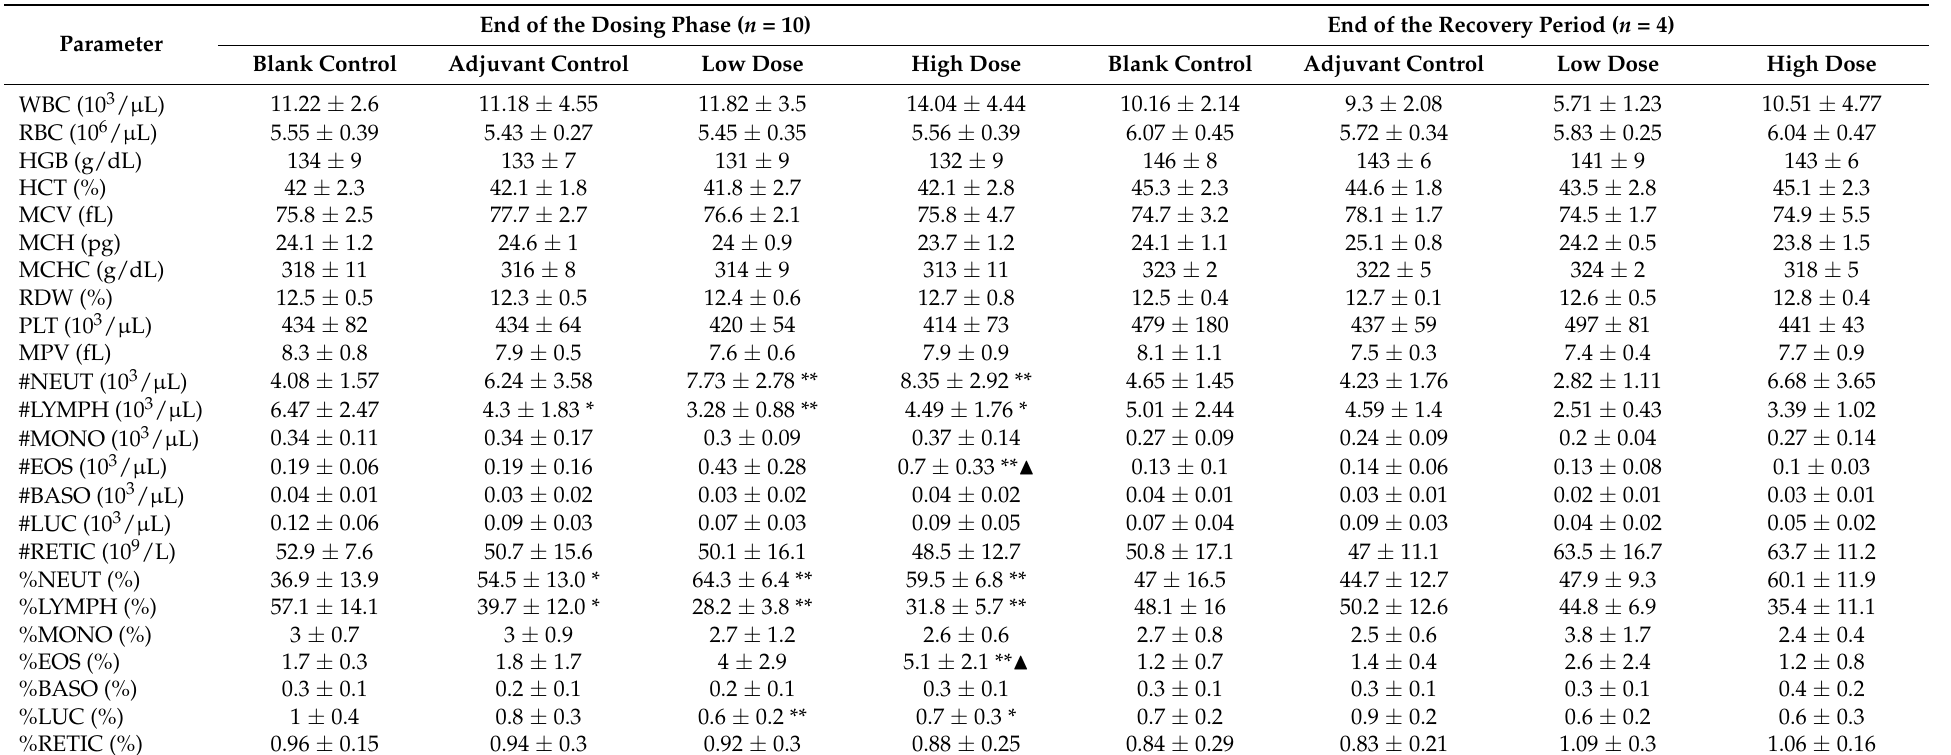
Table 1. The hematology analysis in cynomolgus macaques treated with ZF2001 vaccines in repeat-dose toxicity